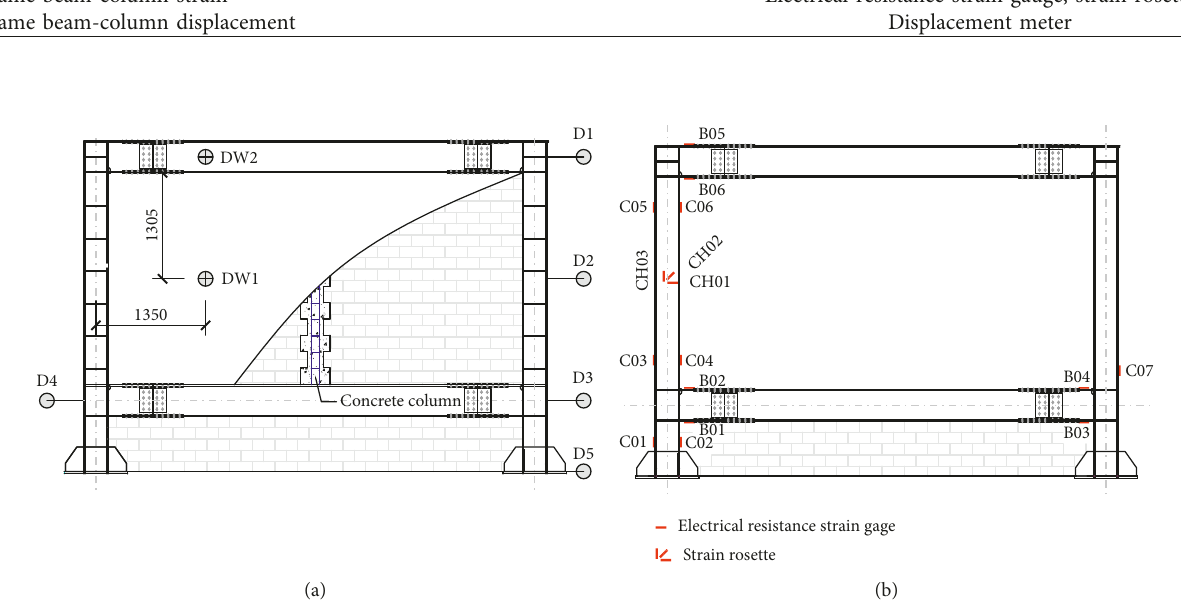
Figure 8: Layout of measuring points: (a) lateral displacement survey layout of steel frame and (b) steel frame strain measurement